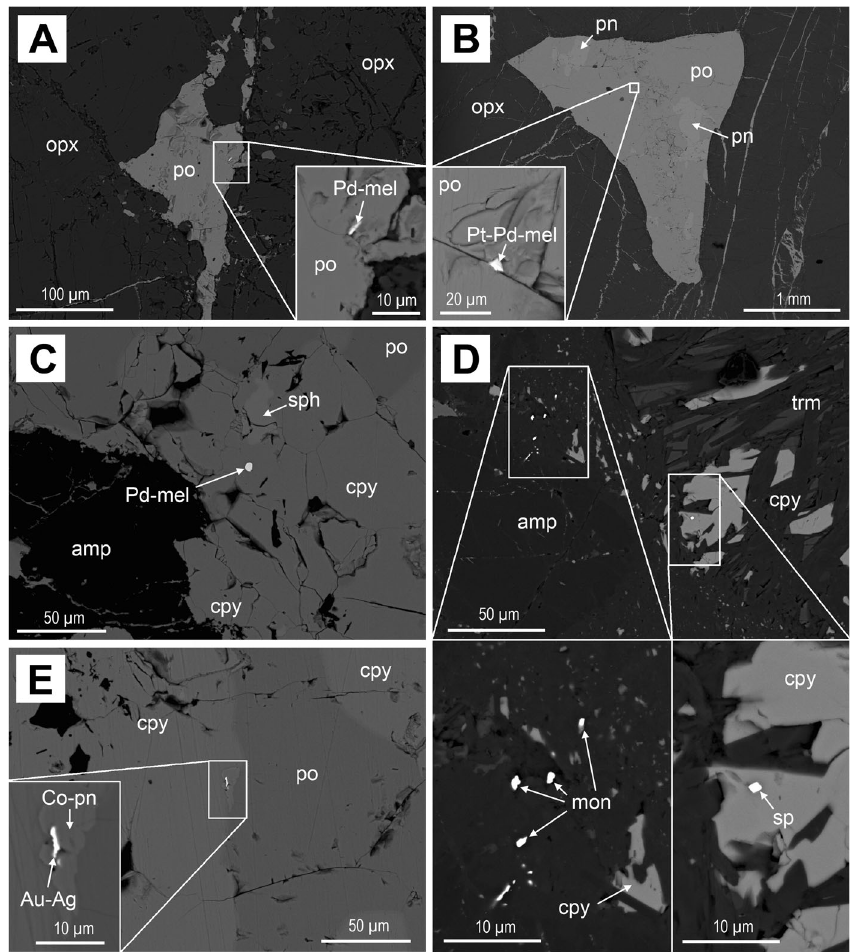
Fig. 4 Precious metal-bearing minerals associated with sul fi des in the samples from the Isola Sill and Sella Bassa. A Palladian-melonite (Pd-mel) inclusion in interstitial pyrrhotite (po) bleb in an orthopyroxene (opx) cumulate from the Isola Sill; B Pt-Pd-bearing melonite in interstitial pyrrhotite- pentlandite (pn) bleb from Sella Bassa; C Palladian-melonite in chalcopyrite (cpy) vein with minor sphalerite (sph) from amphibole (amp)-bearing cumulate from Sella Bassa; D Cluster of moncheite (mon) grains and sperrylite (sp) with chalcopyrite altered to tremolite (trm) from an amphibole-rich cumulate from Sella Bassa; E Au-Ag alloy associated with cobaltian pentlandite (Co-pn) in a chalcopyrite-pyrrhotite vein from Sella